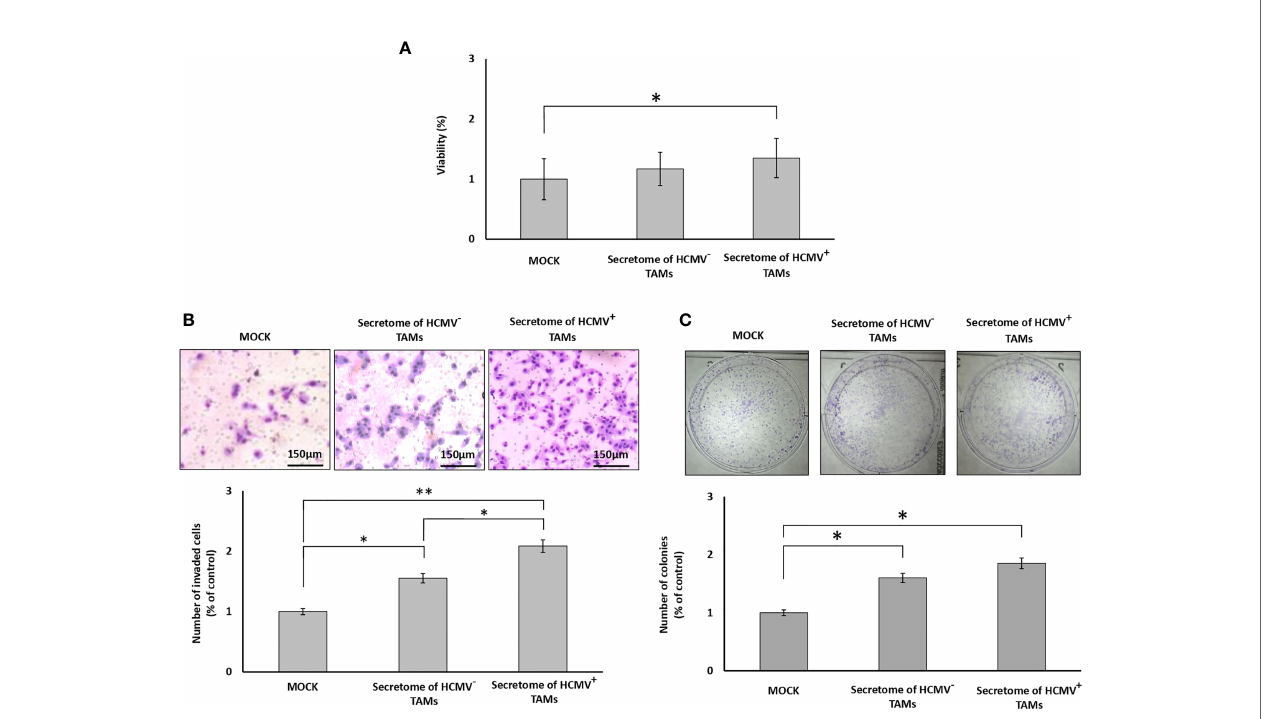
FIGURE 3 | Secretome of HCMV + TAMs enhance proliferation, invasion, and colony formation in SUM149 cells. (A) Bars show cell proliferation percentages of SUM149 cells stimulated by the secretome of HCMV - and HCMV + compared to mock cells. (B) Microscopic images of SUM149 cells that invaded the Coat Matrigel- coated lower chamber in response to the secretome of HCMV - and HCMV + TAMs compared to mock cells. Bars represent the percentage of invasive SUM149 cells in response to the secretome of HCMV - and HCMV + TAMs compared to mock cells. (C) Wells showed the clonogenic ability of SUM149 cells in response to secretome of HCMV - and HCMV + TAMs compared to mock cells. Bars represent the number of colonies of SUM149 cells in response to the secretome of HCMV - and HCMV + TAMs compared to mock cells. Data represented the mean of ± SD (number of experimental replicates = 3). P values were as determined by one-way ANOVA test followed by Tukey ’ s HSD and Post Hoc tests, where * represented ( P < 0.05) and ** represented ( P <